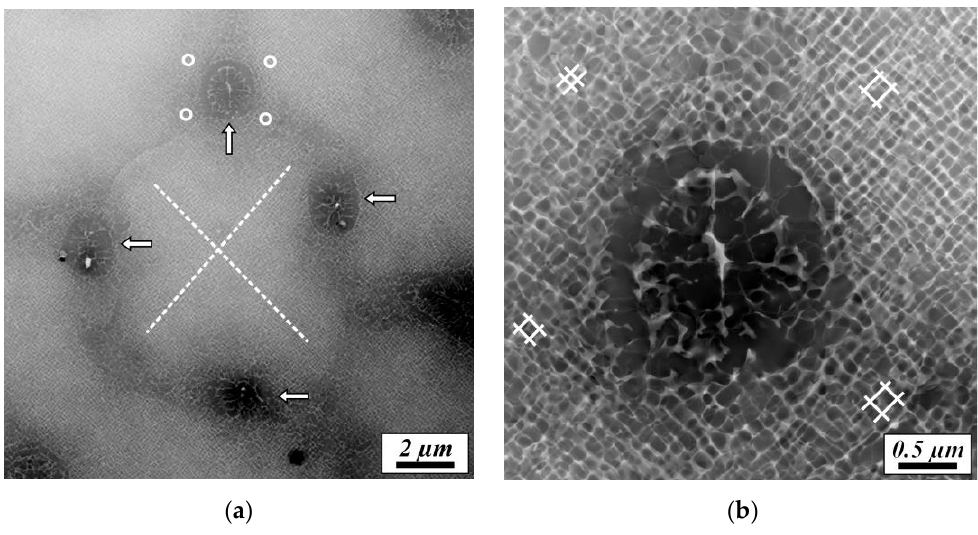
Figure 8. STEM-HAADF microstructures in Specimen B: ( a ) central dendrite surrounded by interdendritic regions with globular microstructures; and ( b ) globular region highlighted by vertical white arrow in Figure 8a at higher magnification.